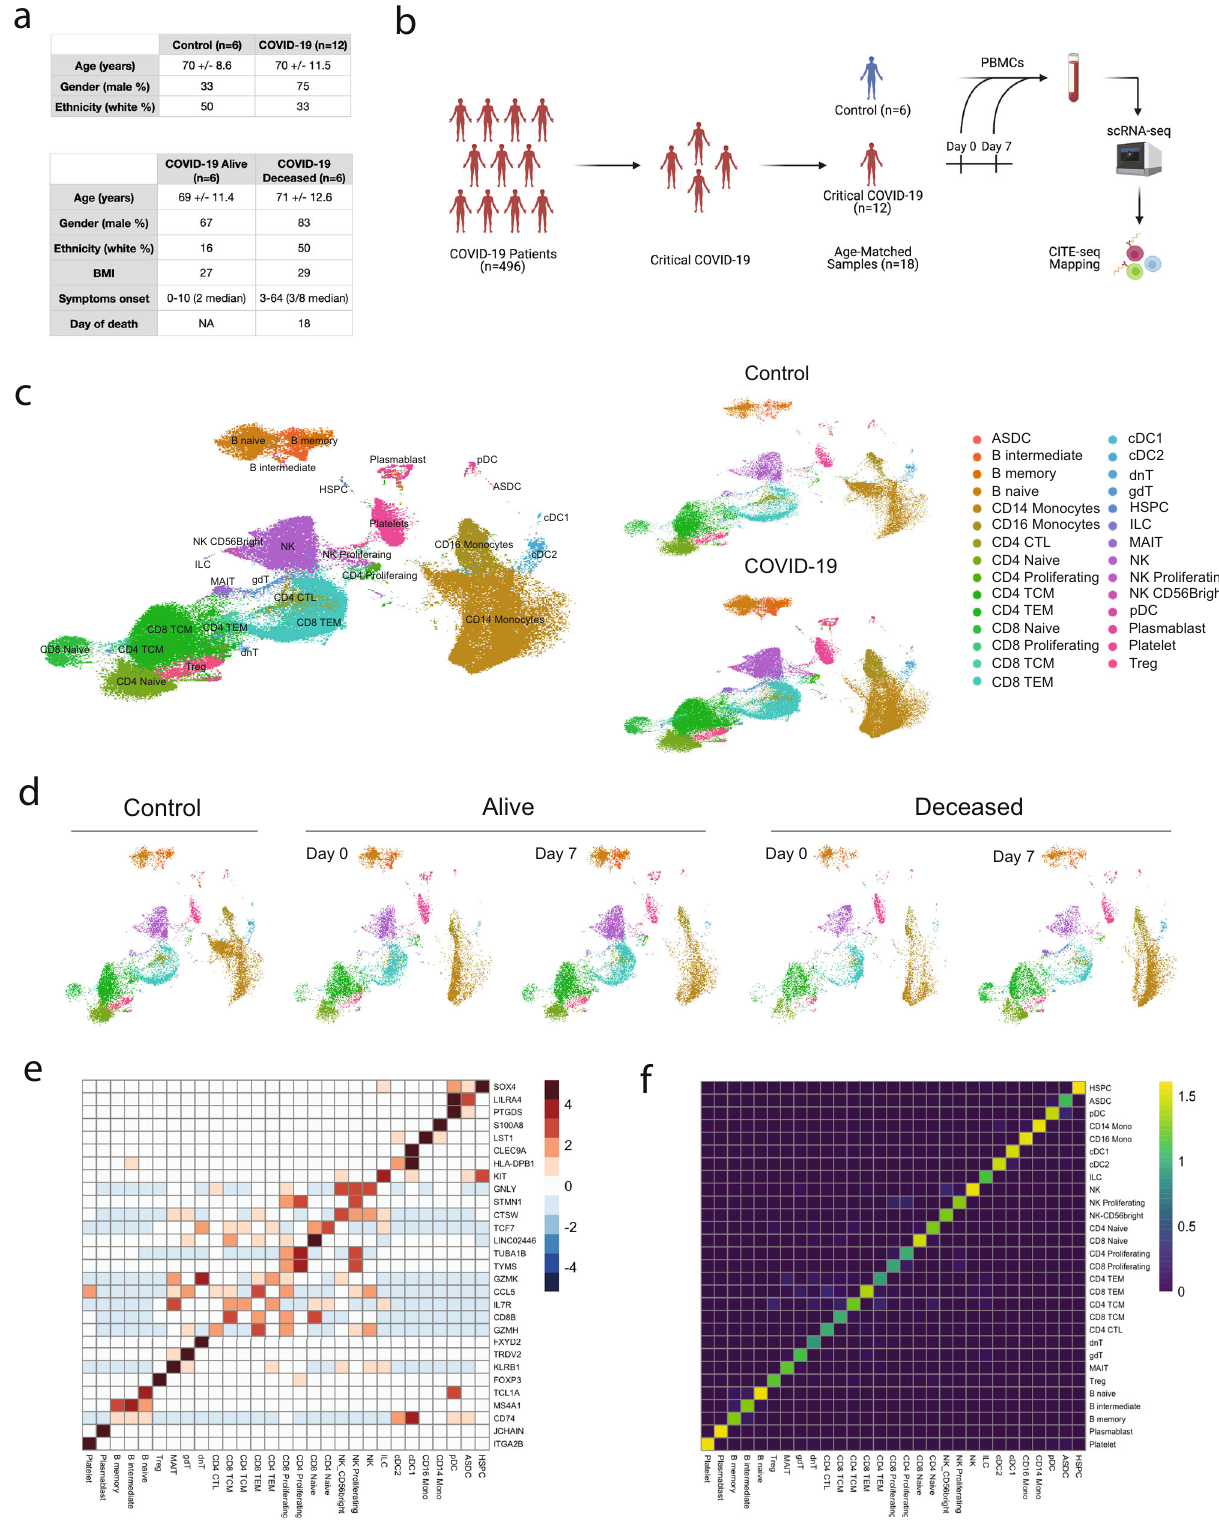
Fig. 1 Single-cell transcriptomic mapping of PBMCs during critical COVID-19. a Demographics and clinical characteristics of patient samples selected for sequencing. b Study design. c UMAP embedding plots of scRNA sequencing pro fi les of 199,097 cells with cluster annotations derived from